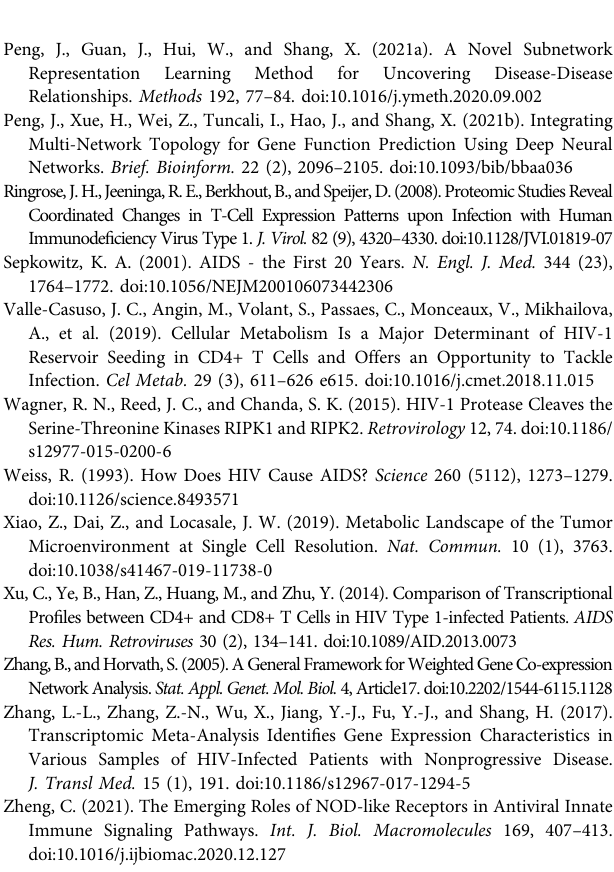
Supplementary Figure 1 | Threshold fi lter. (A) The threshold of the module in CD4 cells is set to 9. (B) The screening of the module threshold in CD8 cells is set at 5. Supplementary Table 1 | Each module of the two types of cells contains the number of genes. Supplementary Table 2 | Key module functions. Two types of cell acute and chronic infections each have a key module, including KEGG enrichment and GO